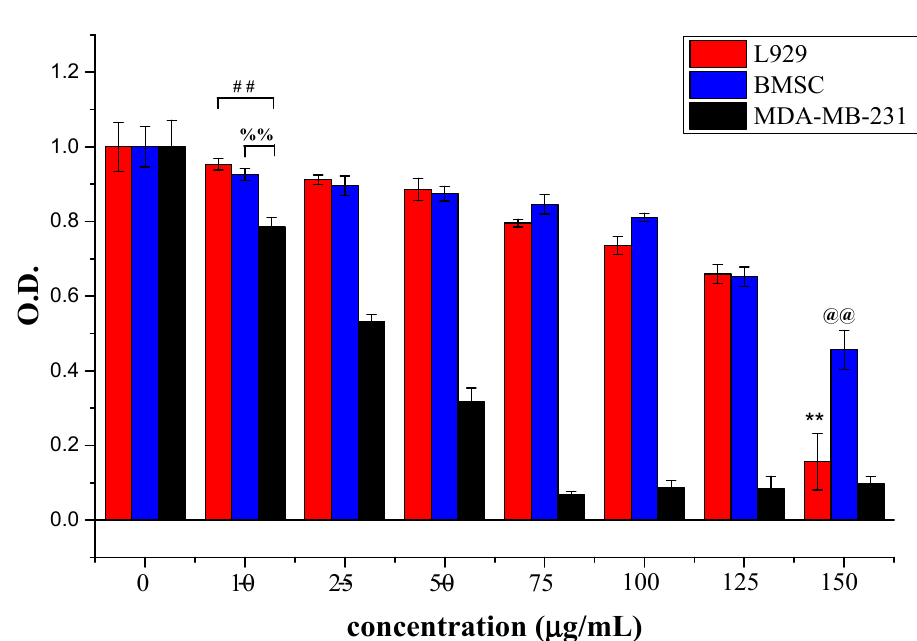
Figure 5. Relative cell numbers determined by the OD value using CCK-8 at 24 h. L929, bone marrow stem cell (BMSC), and MDA-MB-231 cells were treated with ABMP at different concentrations, i.e., 0, 10, 25, 50, 75, 100, 125, and 150 µ g/mL. The experiments were carried out in quadruplicate. Double asterisks (**) and double at (@@) refer to statistical significance p < 0.01 compared with control groups. Double pound (##) refers to a statistical significance of p < 0.01 between the OD values of L929 and MDA-MB-231 after seeding for 24 h; double percent (%%) refers to a statistical significance of p < 0.01 between the OD values of BMSC and MDA-MB-231 after seeding for 24 h.